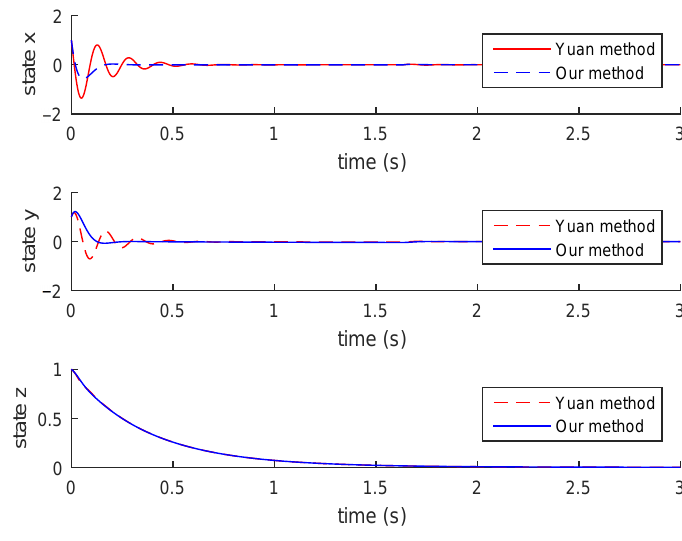
Figure 1. State responses of x , y , z in Example 1.